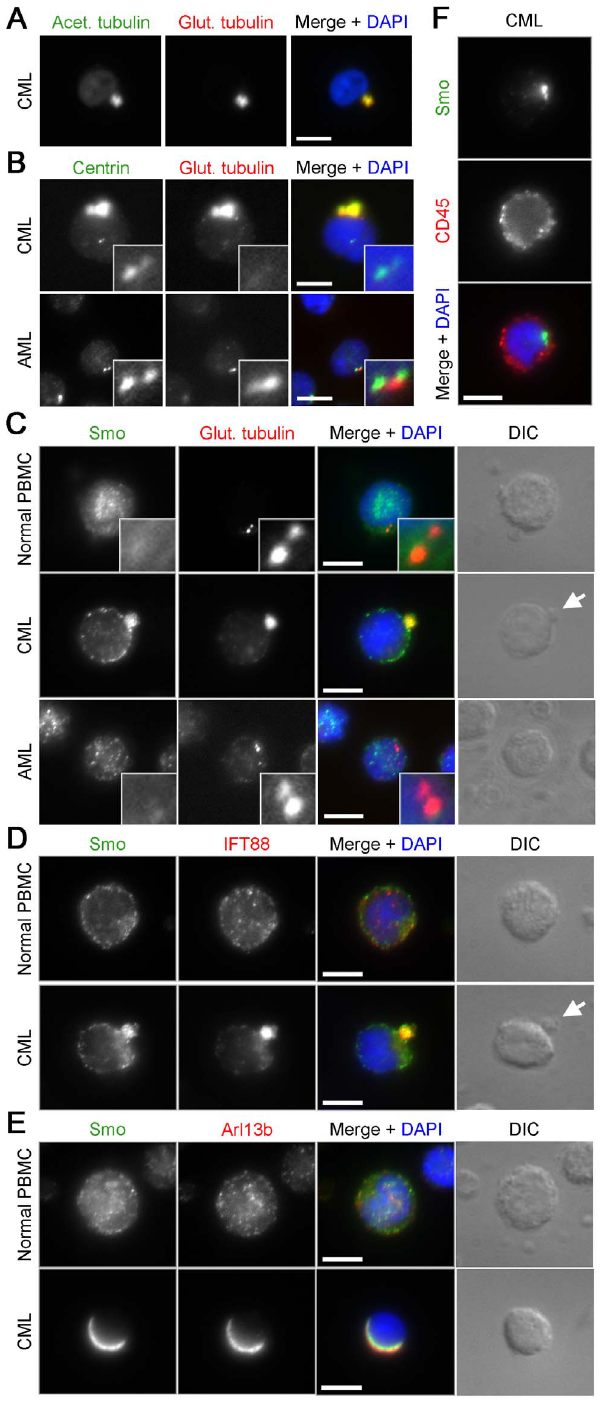
Figure 5. Localization of ciliary proteins in human CML cells. ( A ) Human CML cells stained with antibodies against acetylated (green) and glutamylated tubulin (red). ( B ) CML and AML cells stained with antibodies against centrin (green) and glutamylated tubulin (red). ( C ) Normal PBMC, CML, and AML cells stained with antibodies against Smoothened (Smo) (green) and glutamylated tubulin (red). ( D ) CML cells stained with antibodies against Smo (green) and either IFT88 (red). ( E ) CML cells stained with antibodies against Smo (green) and Arl13b (red). DNA is stained using DAPI (blue), scale bars: 5 m m, insets: 10 6 magnification, white arrows: cell protrusions. In each case . 100 cells were imaged, and the phenotype represented in the images shown was seen in greater than 50% of